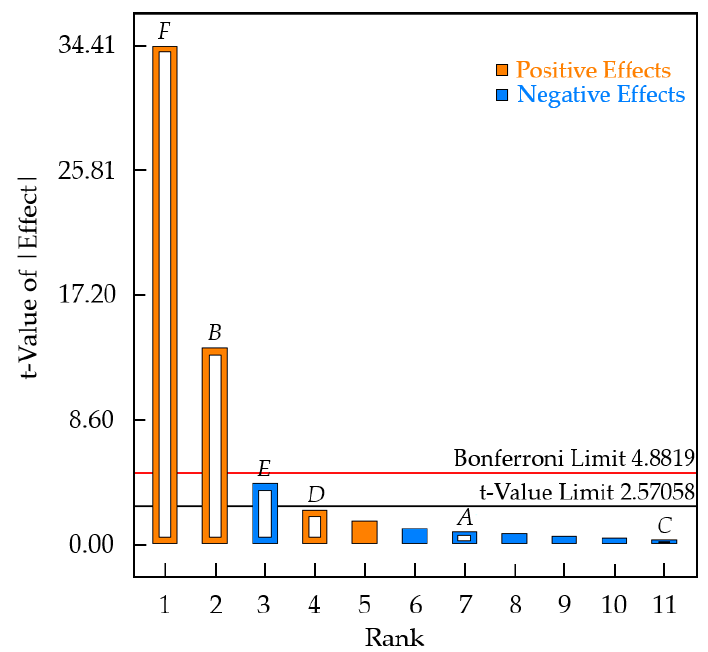
Figure 13. Pareto Figure 13. Pareto chart.